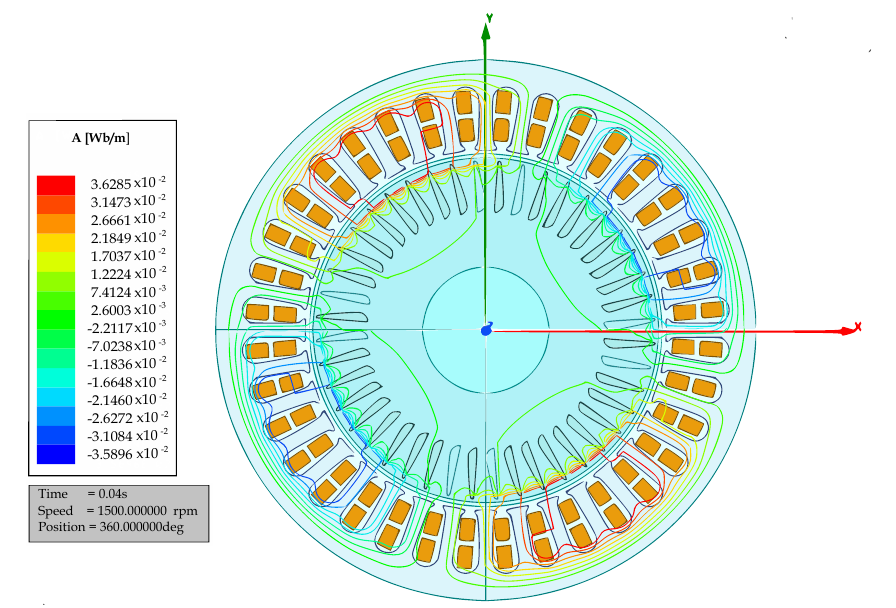
Figure 7. Magnetostatic modeling of a three-phase IM.